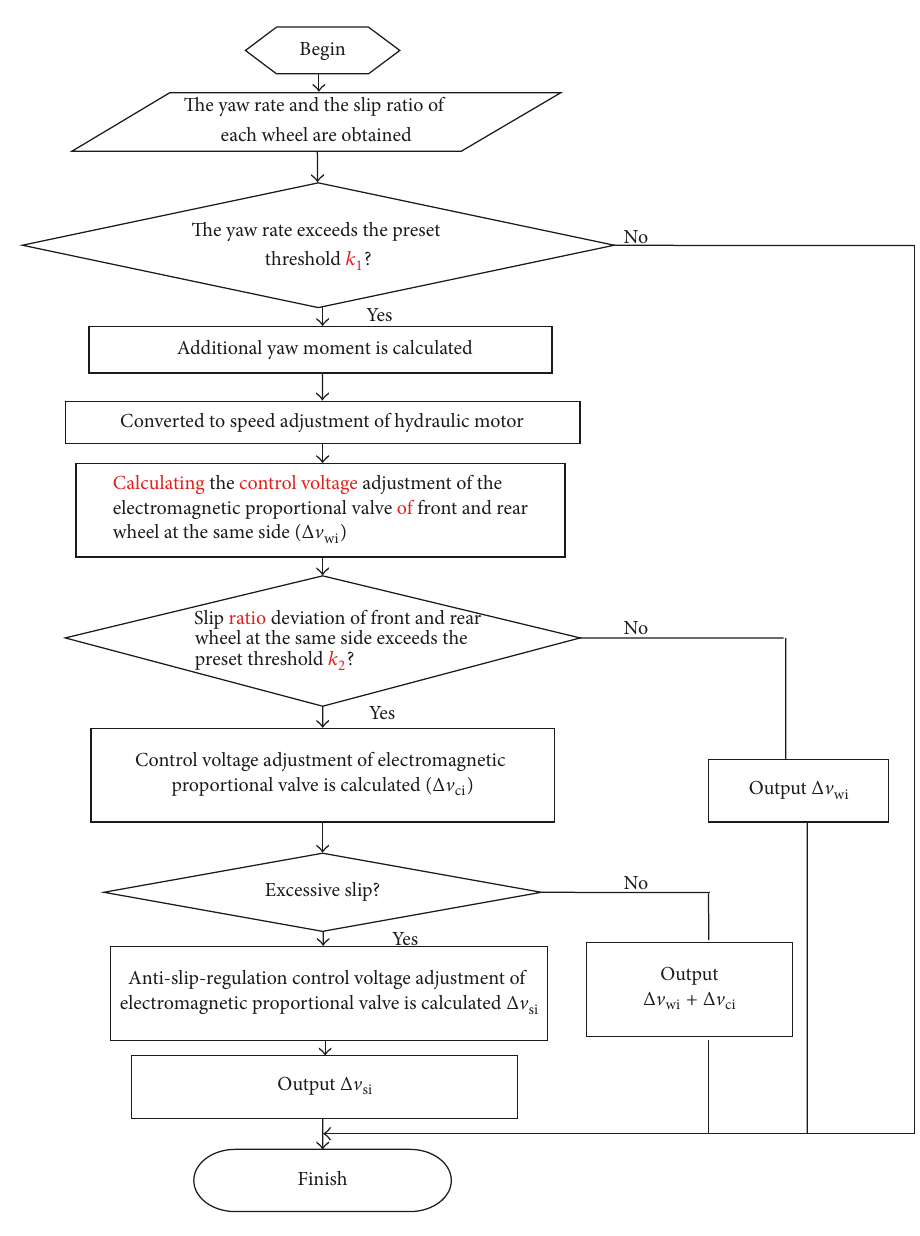
Figure 1: Straight line drive coordinated control strategy of sprayer